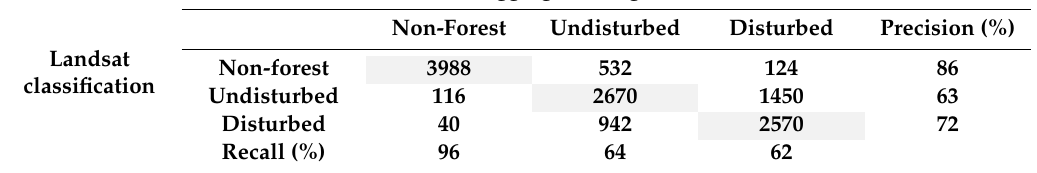
Shaded cells indicate correctly classified pixels. Table A2. Confusion matrix describing Landsat classification accuracy of the Chimney Park, WY study area for aggregated high-resolution pixels that were > 50% pure. Overall classification accuracy was 75% (n = 100,626 pixels).